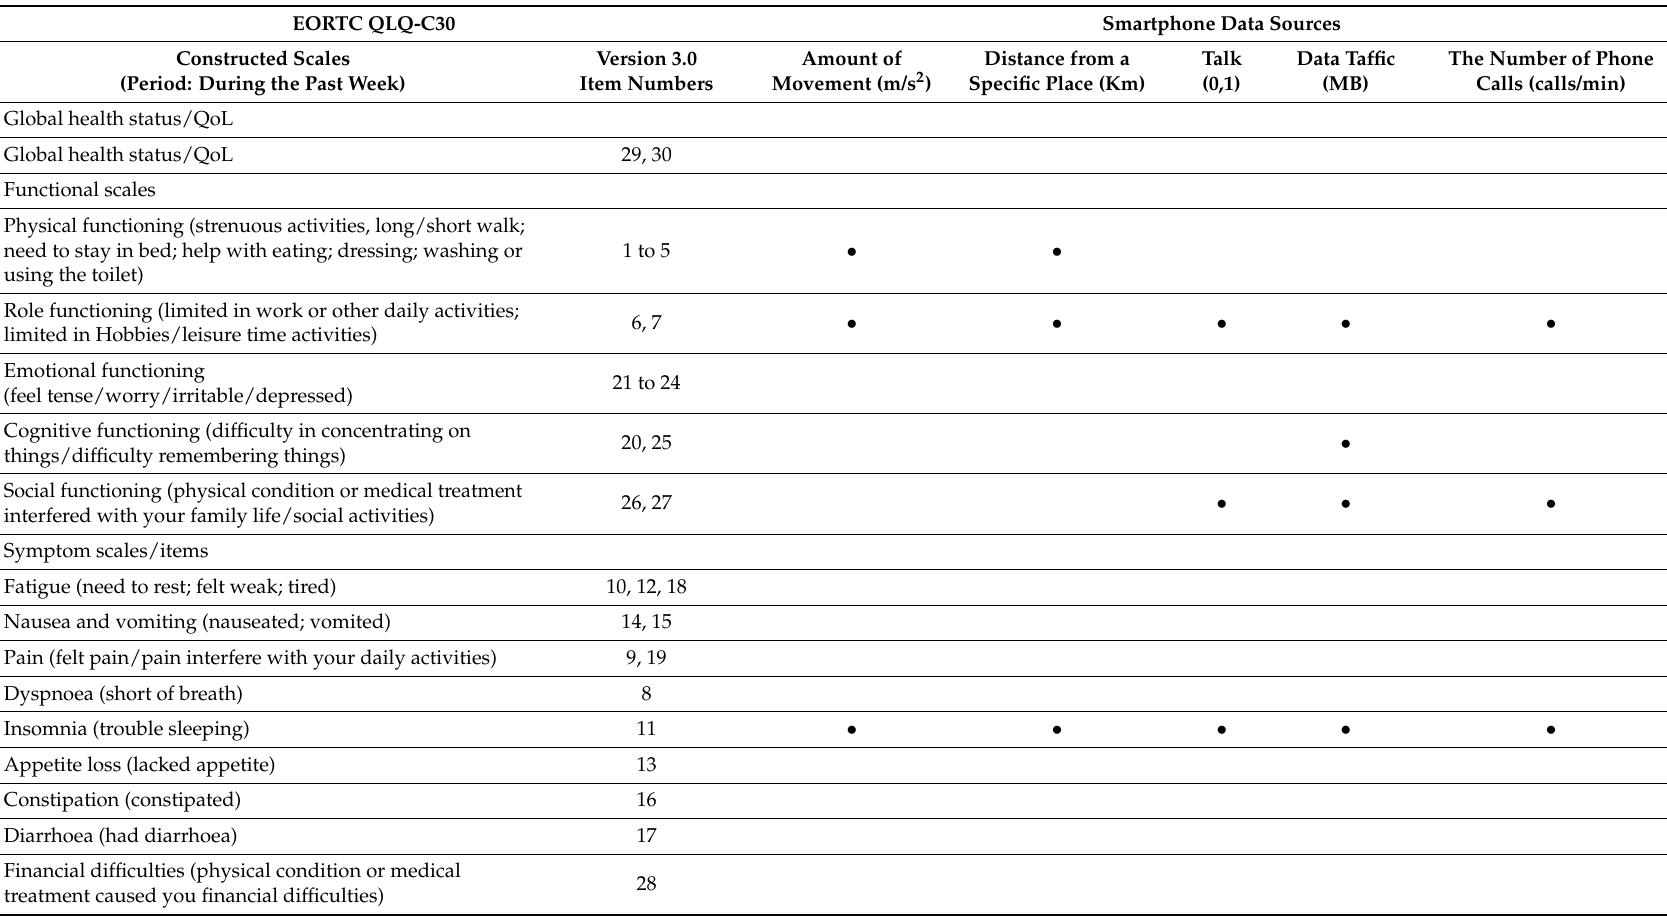
Table 1. Preliminary relationships between the European Organization for the Research and Treatment of Cancer Quality of Life Questionnaire EORTC QLQ-C30 (Version 3.0) items and the Human Dynamics Reporting Service (HDRS) monitoring